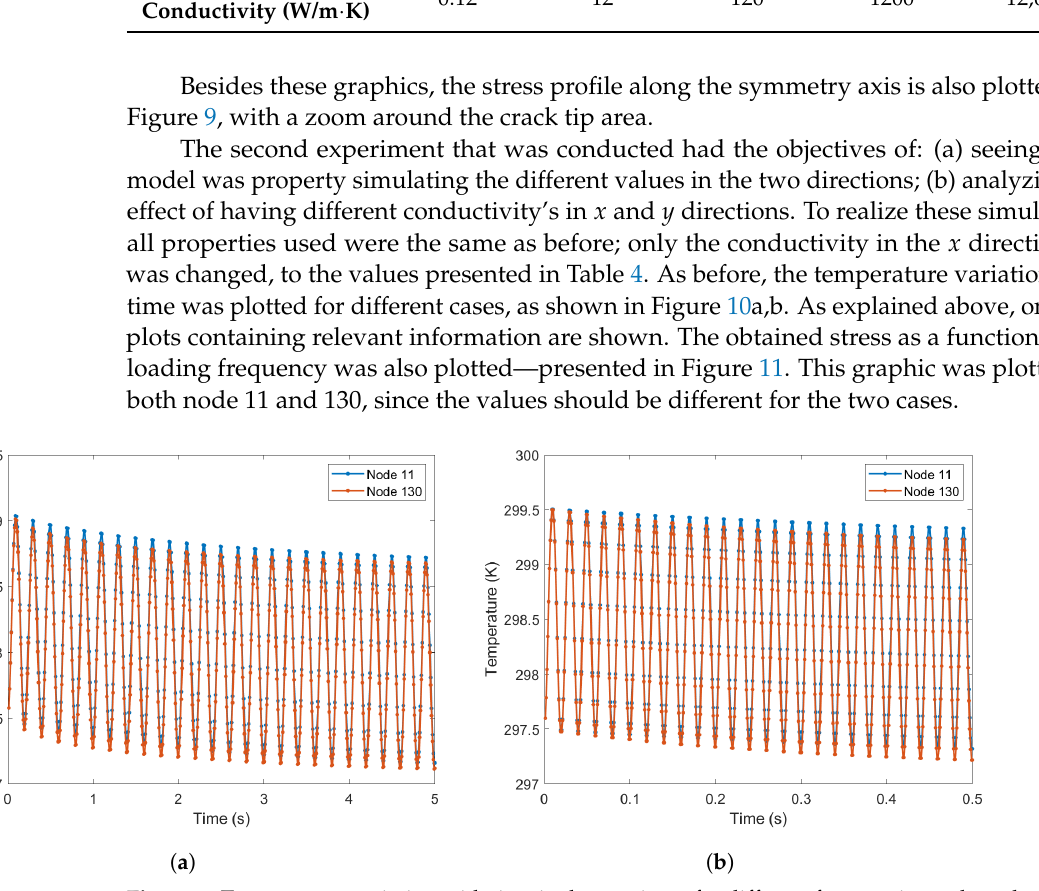
Figure 8. Temperature variation with time in the specimen for different frequencies and